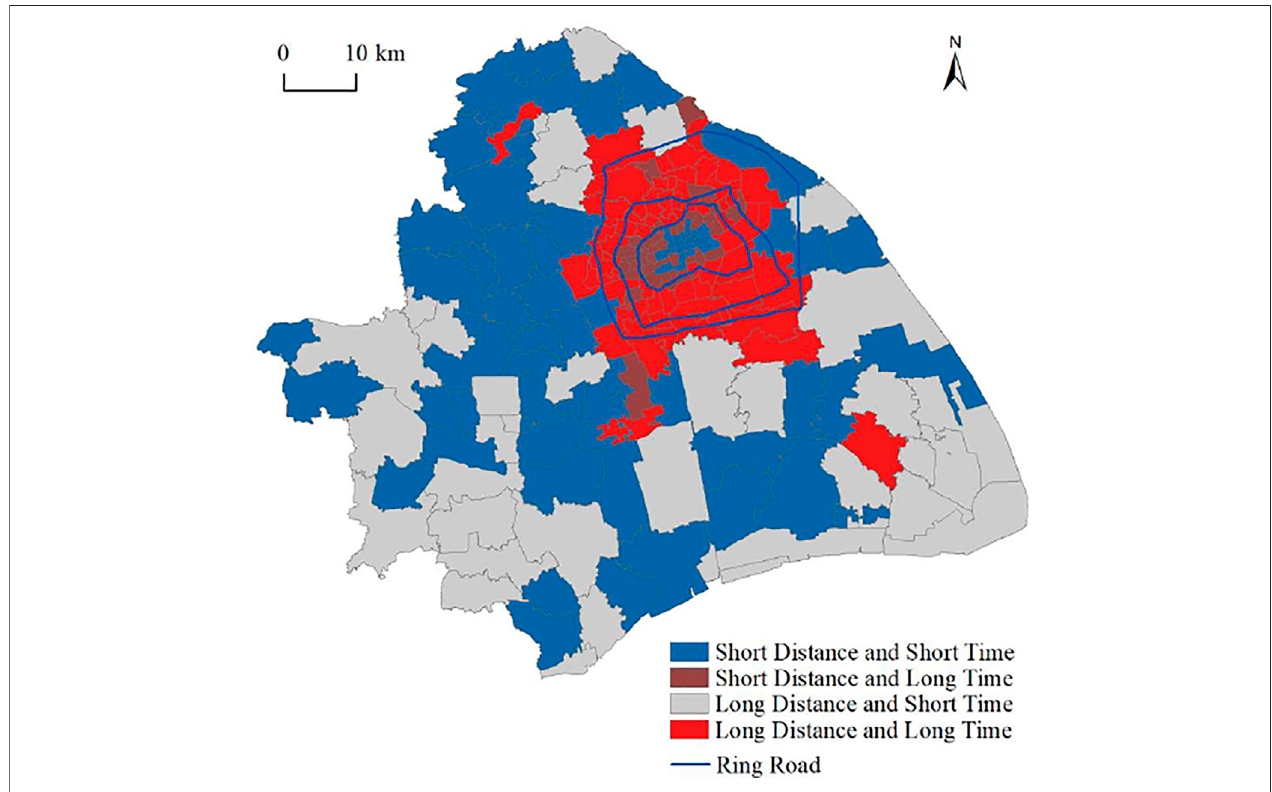
FIGURE 5 | Classi fi cations of commuting level in Shanghai Metropolitan